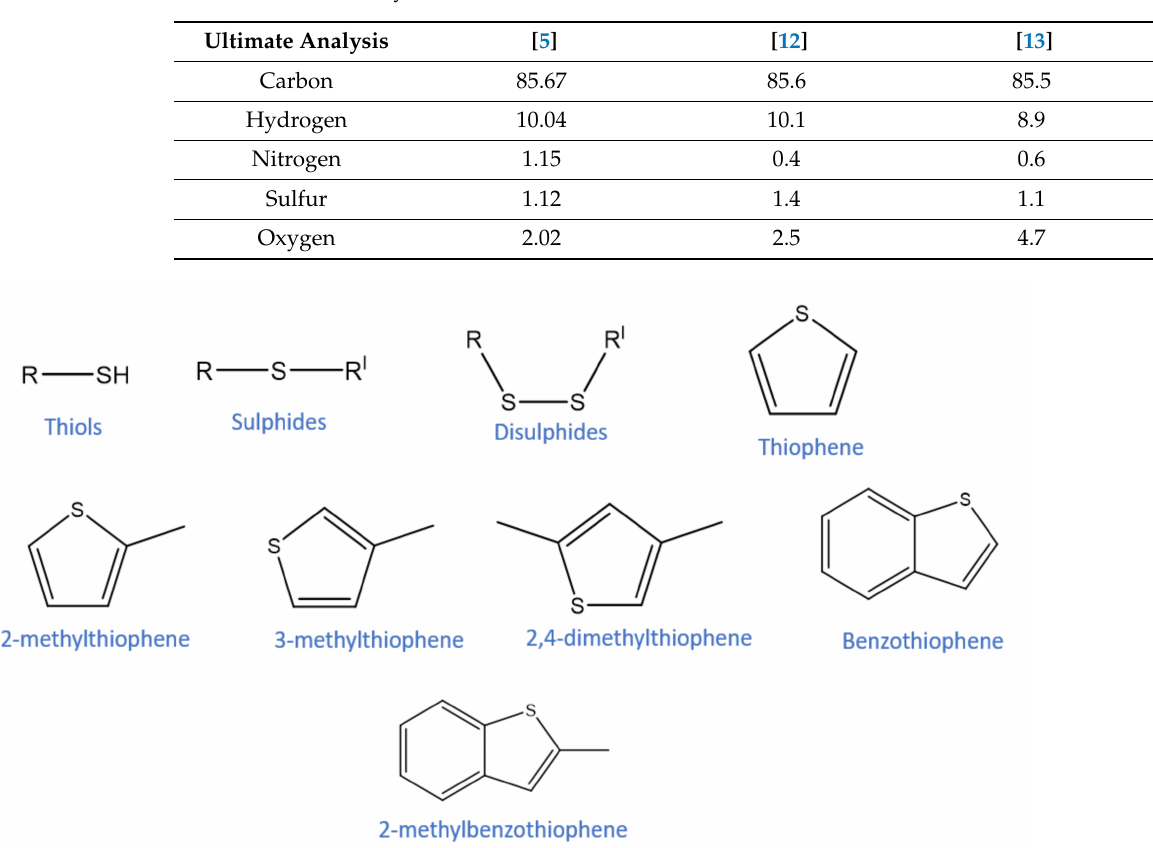
Table 1. Ultimate analysis of WTPO.